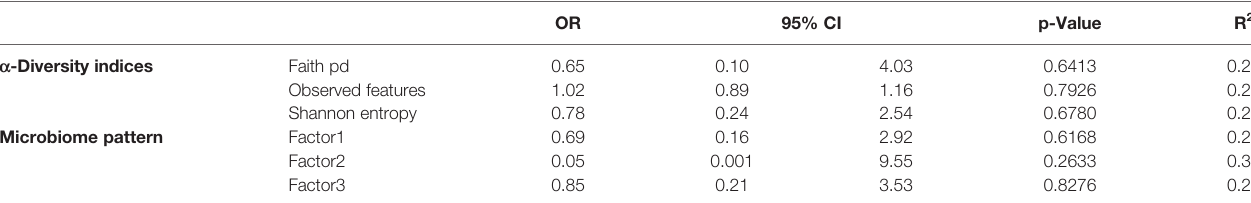
TABLE 4 | Odds ratios for the estimated contribution of each a -diversity index and microbiome pattern to the probability of developing IgG in the entire period of the